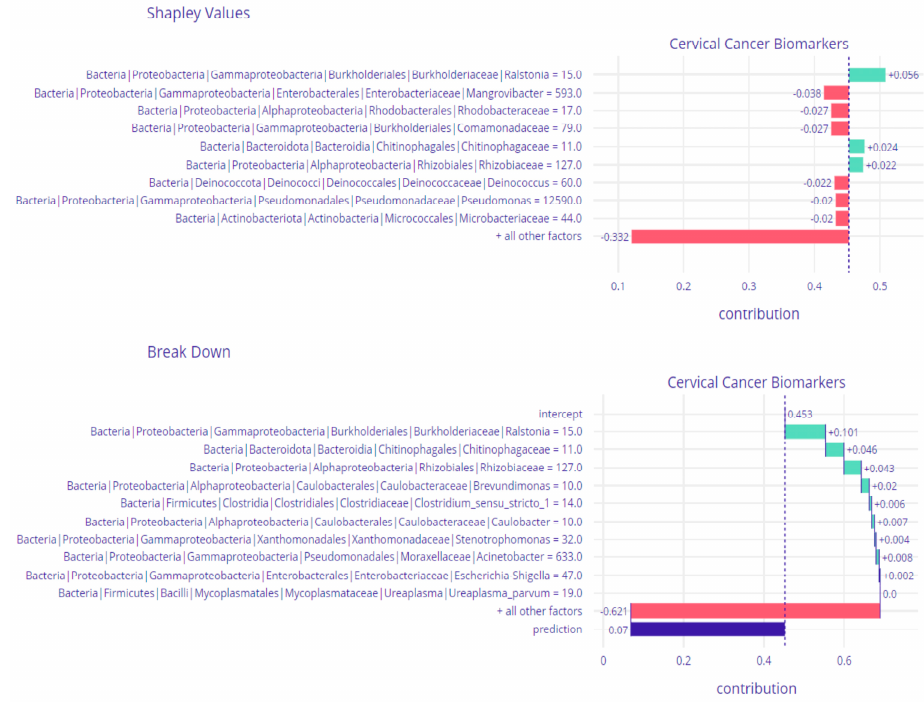
Figure 10 . SHAP explanations for the cervical cancer group, the top bar plot depicts the importance of each feature in terms of SHAP values. The bottom plot represents the feature breakdown. The red bar signifies a declining pattern, whereas the green bar shows an increase in the average response for each feature.